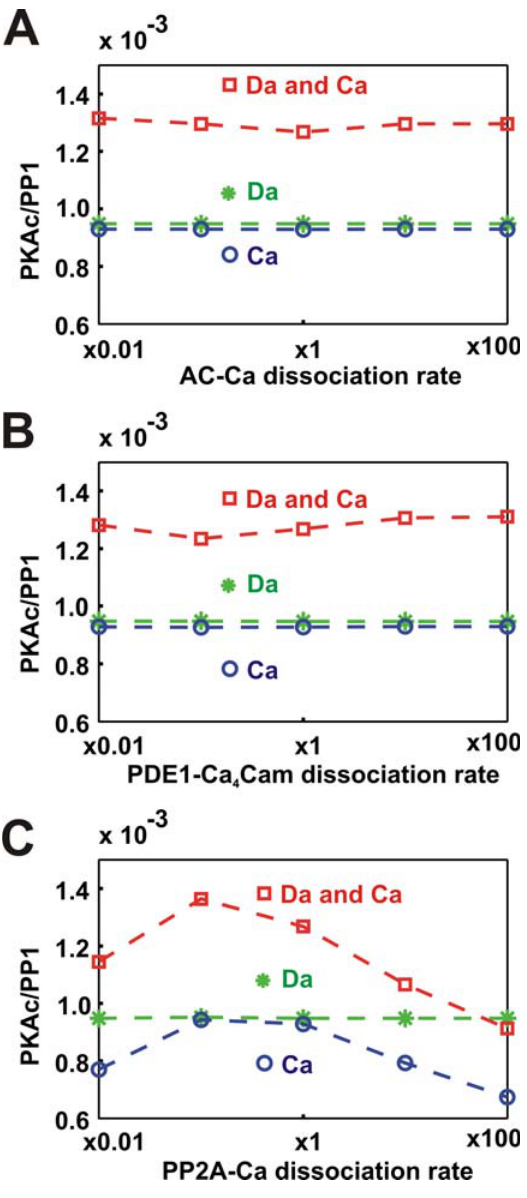
Figure 8. Effects of Dissociation Rate on Calcium Enhancement of Dopamine-Induced PKAc Elevation and PP1 Suppression In all panels, the response is the maximal ratio of PKAc to PP1. All panels show the effect of dissociation rate on the response to dopamine alone (green dashed line, stars), calcium alone (blue dashed line, circles), and paired dopamine and calcium (red dashed line, squares). (A) Response is independent of rate of calcium-dependent AC5 inhibition. (B) Response is independent of rate of Ca 4 CaM binding to PDE1. (C) Response is slightly sensitive to the rate of calcium binding to PP2A: for very fast (*100) calcium dissociation rate, the enhancing role of calcium decreases because the activation of PP2A is too brief to dephosphorylate significant amounts of phosphoThr75 following brief calcium